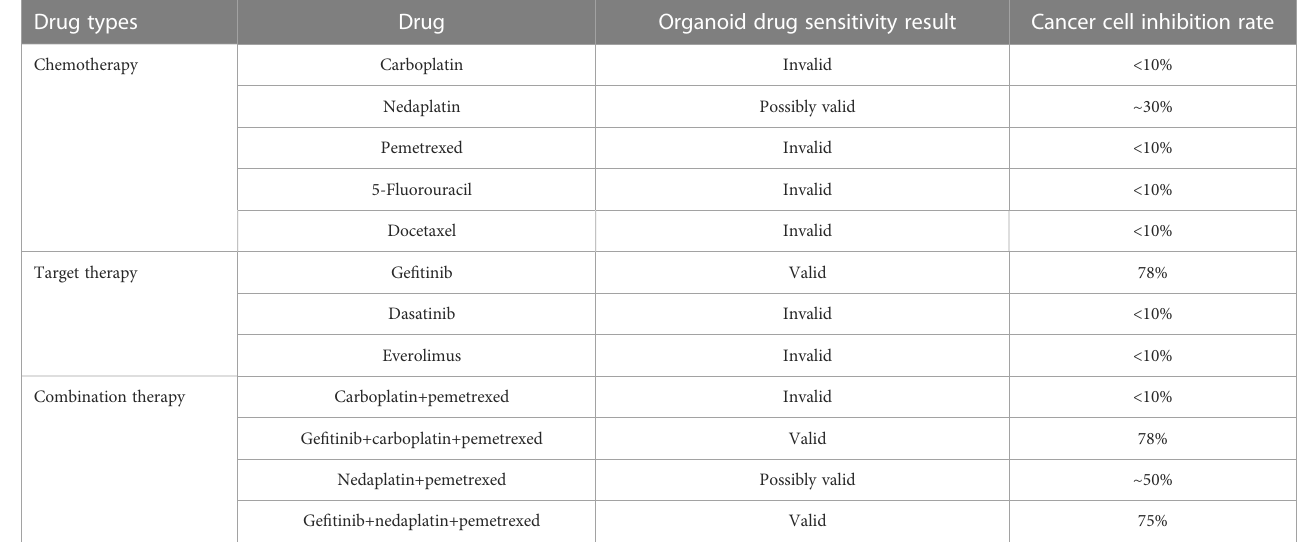
TABLE 2 The PDO drug screening result from K2 Oncology Laboratory.